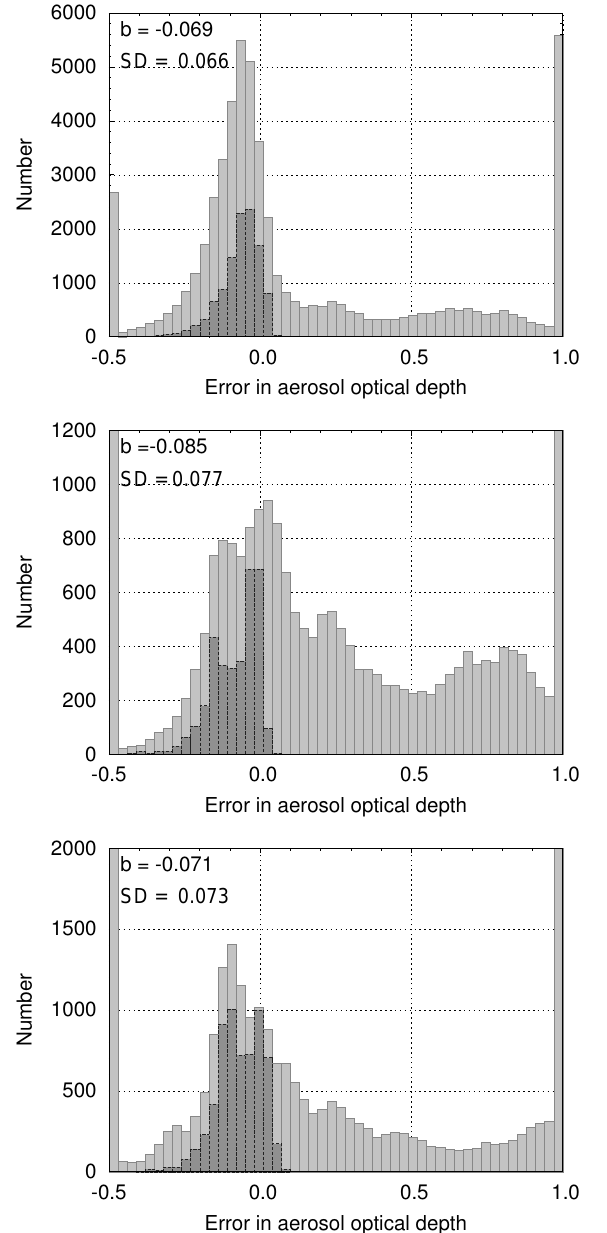
Figure 10. Histograms of the errors in retrieved aerosol optical depth in the O 2 A-band for experiments 1, 2 and 3 (top, middle and bottom). The PPF has been applied to the dark grey histograms, but not to those in light grey. The bias (b) and standard deviation (SD) quoted are for the histogram after the PPF.